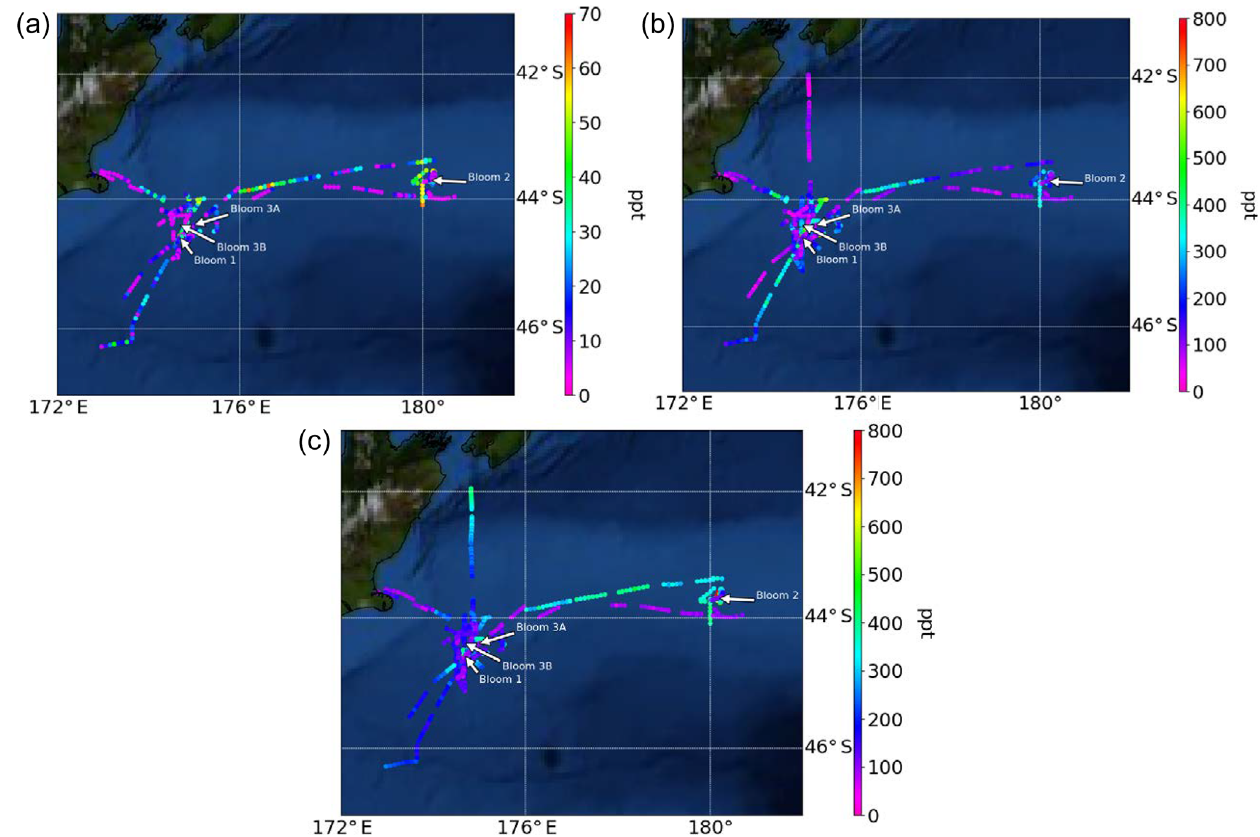
Figure 3. Atmospheric mixing ratios of (a) MeSH a , (b) DMS a and (c) acetone a as a function of the voyage track. Location of the blooms are